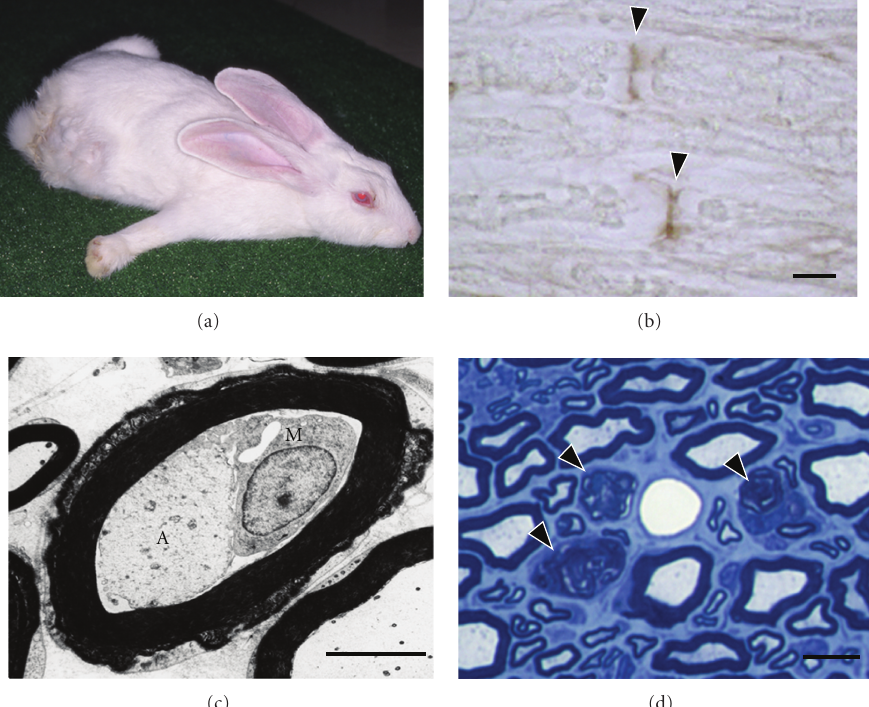
Figure 2: Characteristic findings for the acute motor axonal neuropathy rabbit model. (a) Rabbit with flaccid limb weakness induced by sensitization with Campylobacter jejuni lipo-oligosaccharide. Its body is splayed, all extremities extended, head on the floor not sitting upright in the usual compact, hunched posture. (b) Longitudinal section of the cauda equina. The nodes of Ranvier are stained selectively with protein G (arrowheads). Scale bar, 10 μ m. (c) Electron micrograph of a nerve fiber with macrophage infiltration. A macrophage (M) occupies the periaxonal space between the atrophic axon (A) and surrounding myelin sheath which appears almost normal. Scale bar, 5 μ m. (d) Wallerian-like degeneration of nerve fibers in a paralyzed rabbit killed 39 days after onset. Sciatic nerve cross section with toluidine blue stain. Myelin ovoids produced by Wallerian-like degeneration of myelinated fibers are present (arrowheads). Scale bar, 10 μ m. Muscle Nerve 35:691–711, Copyright 2007, John Wiley & Sons,